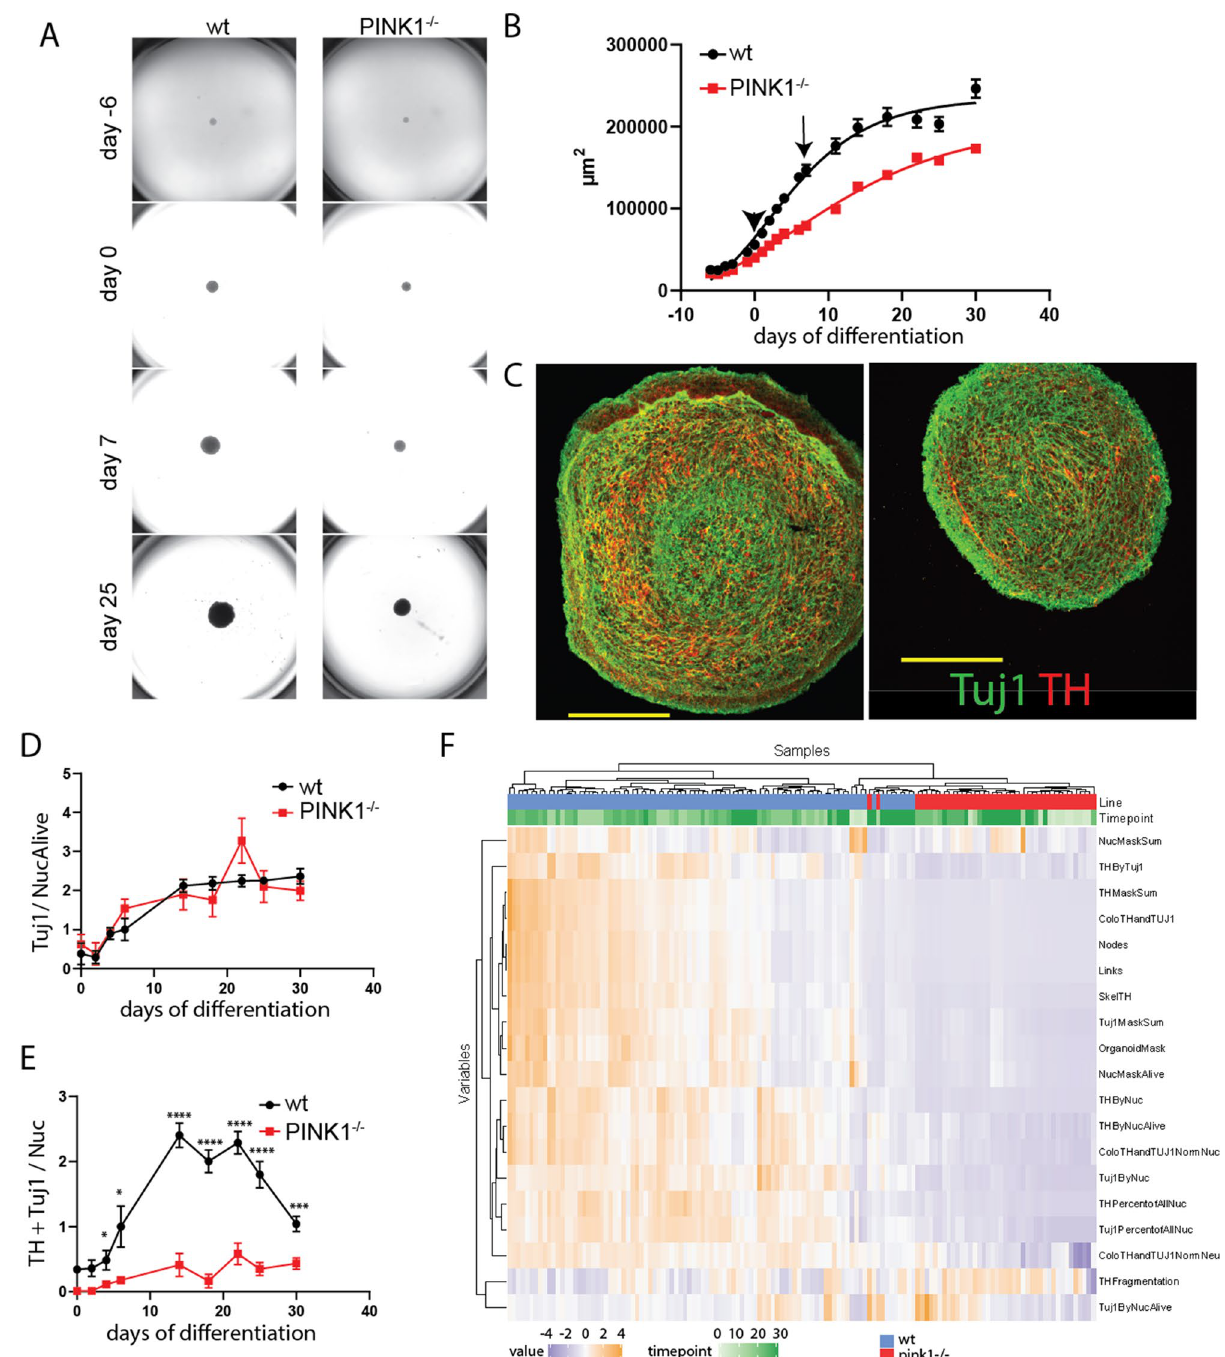
Figure 7. Impaired dopaminergic differentiation in human pink1 -/- midbrain-specific organoids. ( A ) Representative bright field images of midbrain-specific organoids at different time points of differentiation. ( B ) Quantification of the size of the organoids by measuring their area in the images shown in ( A ). Arrow head indicates start of differentiation and arrow indicates start of maturation. Data points represent mean ± SEM. N = 3 independent generations of organoids, each starting with 48 organoids/line. ( C ) Representative images of day 30 midbrain-specific organoids sections (wt left, pink1-/- right) stained for Tuj1 (green) and TH (red). ( D ) Quantification of neuronal content of organoid sections measured as sum of Tuj1 positive pixels (neuronal marker) normalized by Hoechst positive pixels (nucleus marker) at day 0, 2, 4, 6, 14, 18, 22, 25, and 30 of differentiation. ( E ) Quantification of dopaminergic neuronal content measured as sum of Tuj1/TH double positive pixels normalized by Hoechst positive pixels. Data points represent mean ± SEM. P values are calculated by two-tailed Mann–Whitney-test. N = 3 independent generations of organoids, * p < 0.05, *** p < 0.001 **** p < 0.0001. ( F ) Heatmap displaying the features extracted from the image analysis and cluster